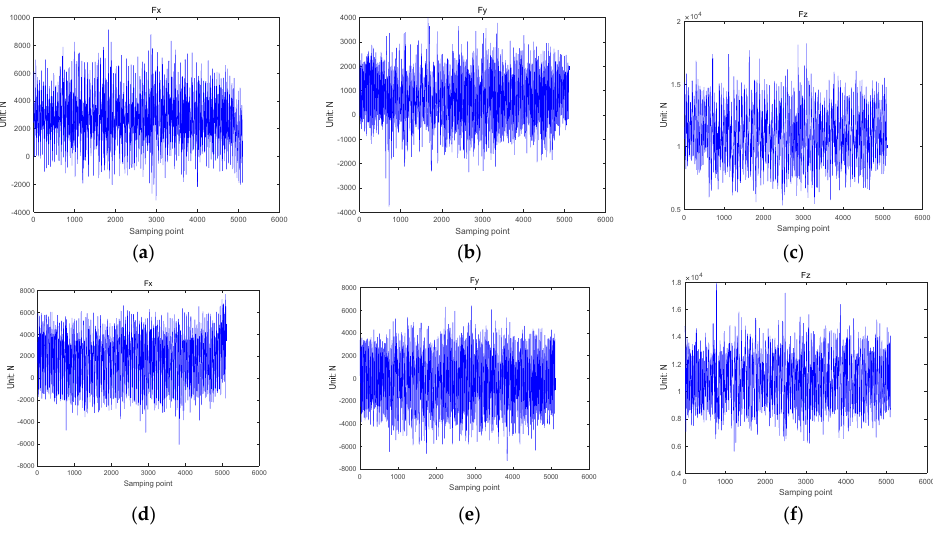
Figure 6. The original loads on the target road, ( a ) F x of the left WFS, ( b ) F y of the left WFS, ( c ) F z of the left WFS, ( d ) F x of the right WFS, ( e ) F y of the right WFS, ( f ) F z of the right